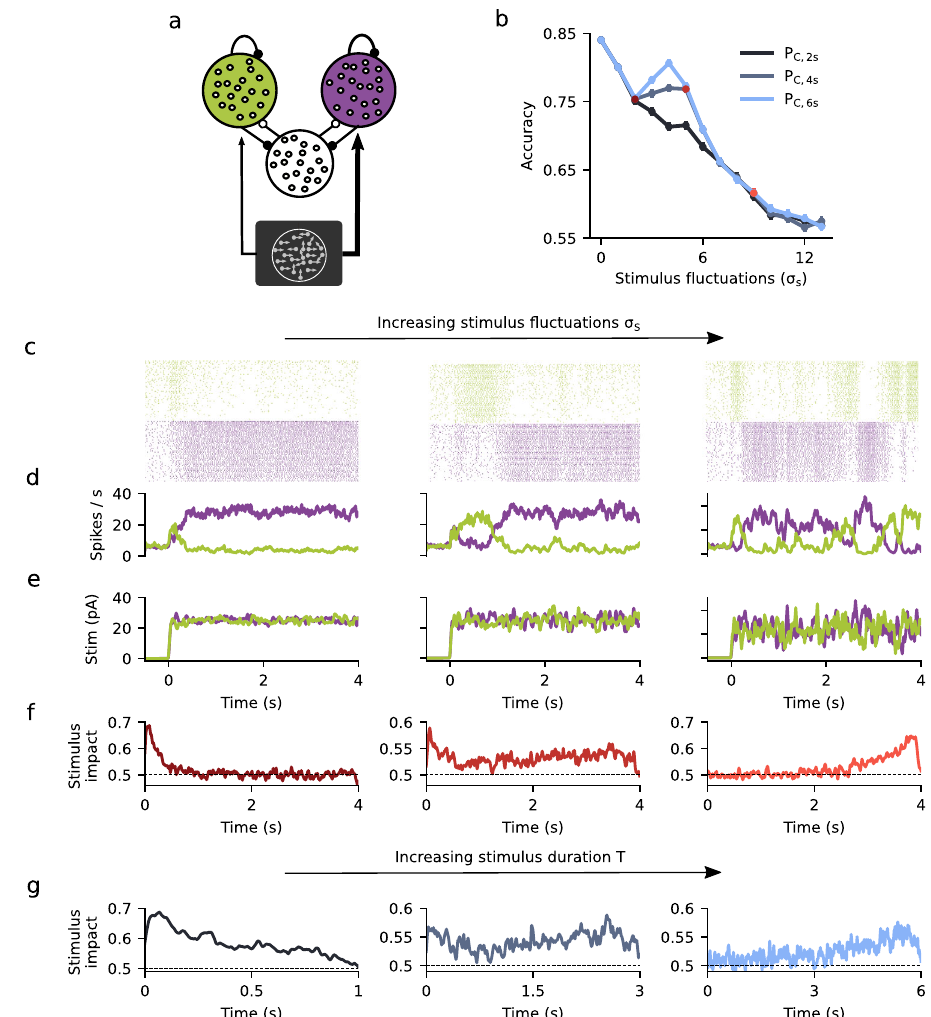
Fig. 5 Signatures of fl exible categorization dynamics in a spiking network. a Schematic of the spiking network consisting of two stimulus-selective populations (green and purple) made of excitatory neurons that compete through an untuned inhibitory population (white population). b Accuracy P C versus stimulus fl uctuations σ S obtained from simulations of the spiking network for three values of the stimulus duration T = 2, 4, and 6 s (see inset). c – e Single-trial examples showing spike rastergram from the two excitatory populations (1000 + 1000 neurons) ( c ), traces of the instantaneous population rates (count window 30 ms) ( d ) and of the input stimuli ( e ), for different values of stimulus fl uctuations σ S = 2 (left), 4.5 (middle), and 9 pA (right). Colored points in ( b ) indicate the σ S used. f Psychophysical kernels obtained for each σ S value. The mean stimulus input was μ = 0.015 and the stimulus duration T = 4 s. g Psychophysical kernels for σ S = 5 pA and different stimulus duration T = 1, 3, and 5 s, from left to